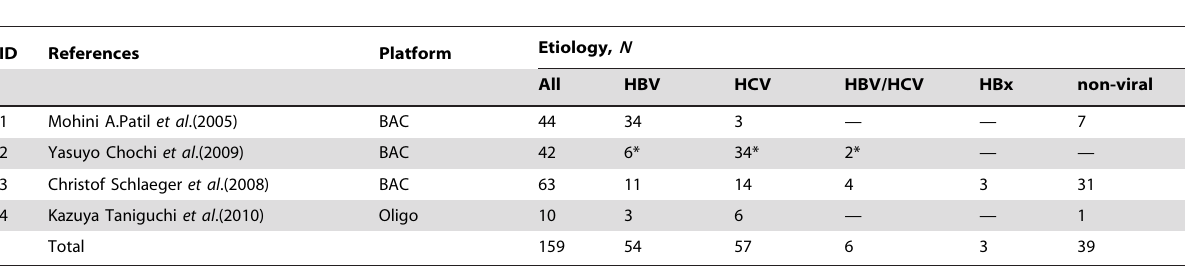
Table 1. Information of 4 collected public datasets